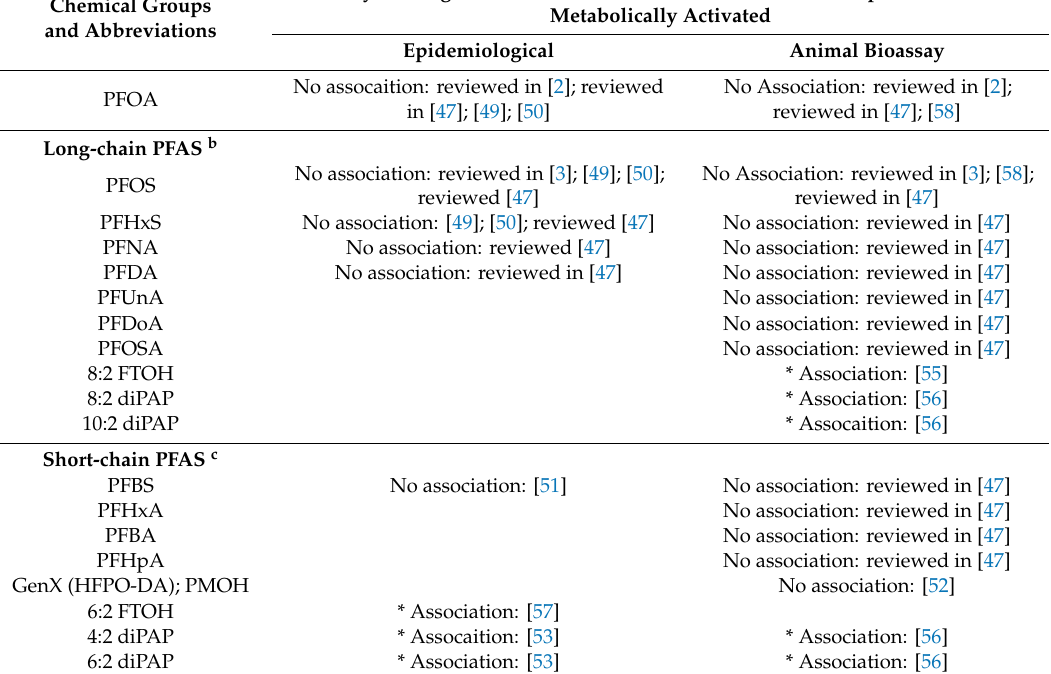
Table 2. Chemical specific study findings for key characteristic one—is electrophilic or can be metabolically